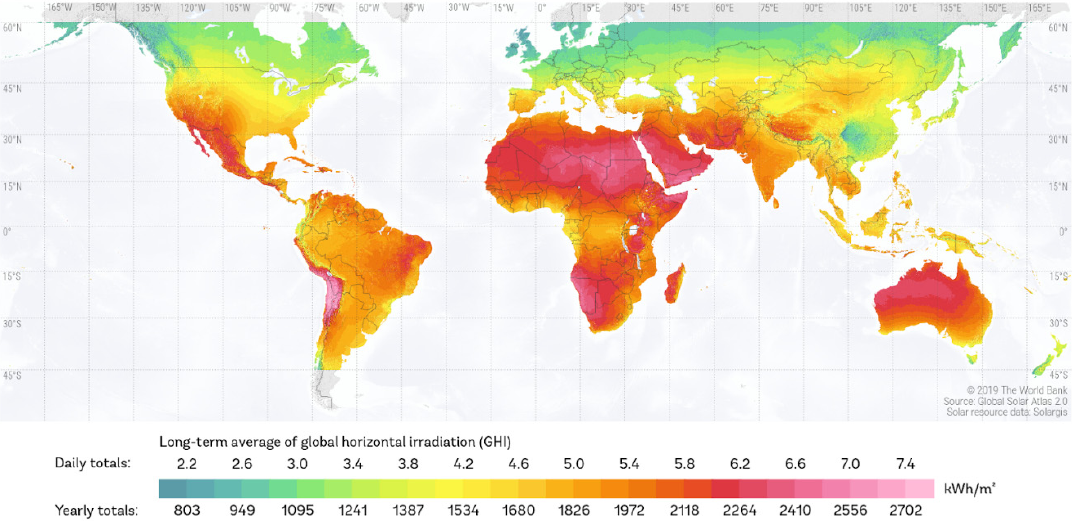
Figure 6. Global horizontal irradiation (Global Solar Atlas).